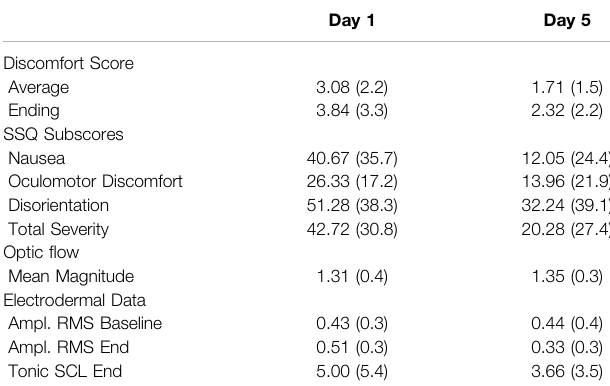
TABLE 1 | Summary results of discomfort scores, simulator sickness questionnaire, optic fl ow, and electrodermal data for the testing days in terms of mean (standard deviation)